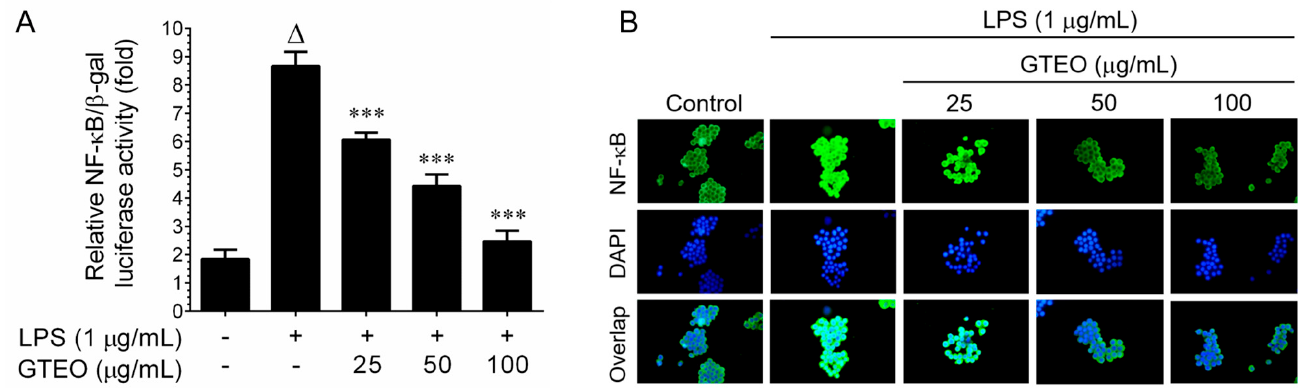
Figure 3. Effect of GTEO on LPS-induced transcriptional activation of NF- κ B. ( A ) RAW 264. 7 cells were co-transfected with NF- κ B harboring luciferase reporter construct. After transfection, cells were stimulated with LPS (1 μ g/mL) and incubated in the presence or absence of GTEO (25–100 μ g/mL) and in the presence of 1 μ g/mL LPS for 2 h. Luciferase activity was determined and normalized with β -galactose activity. ( B ) The LPS-induced nuclear export of NF- κ B was determined by immunofluo- rescence staining as described in materials and methods. Data are reported as mean ± SD of three independent experiments. ∆ p < 0.001 indicates a significant difference between the control and LPS-only treated groups. *** p < 0.001 show significant differences between the LPS-alone and GTEO treatment